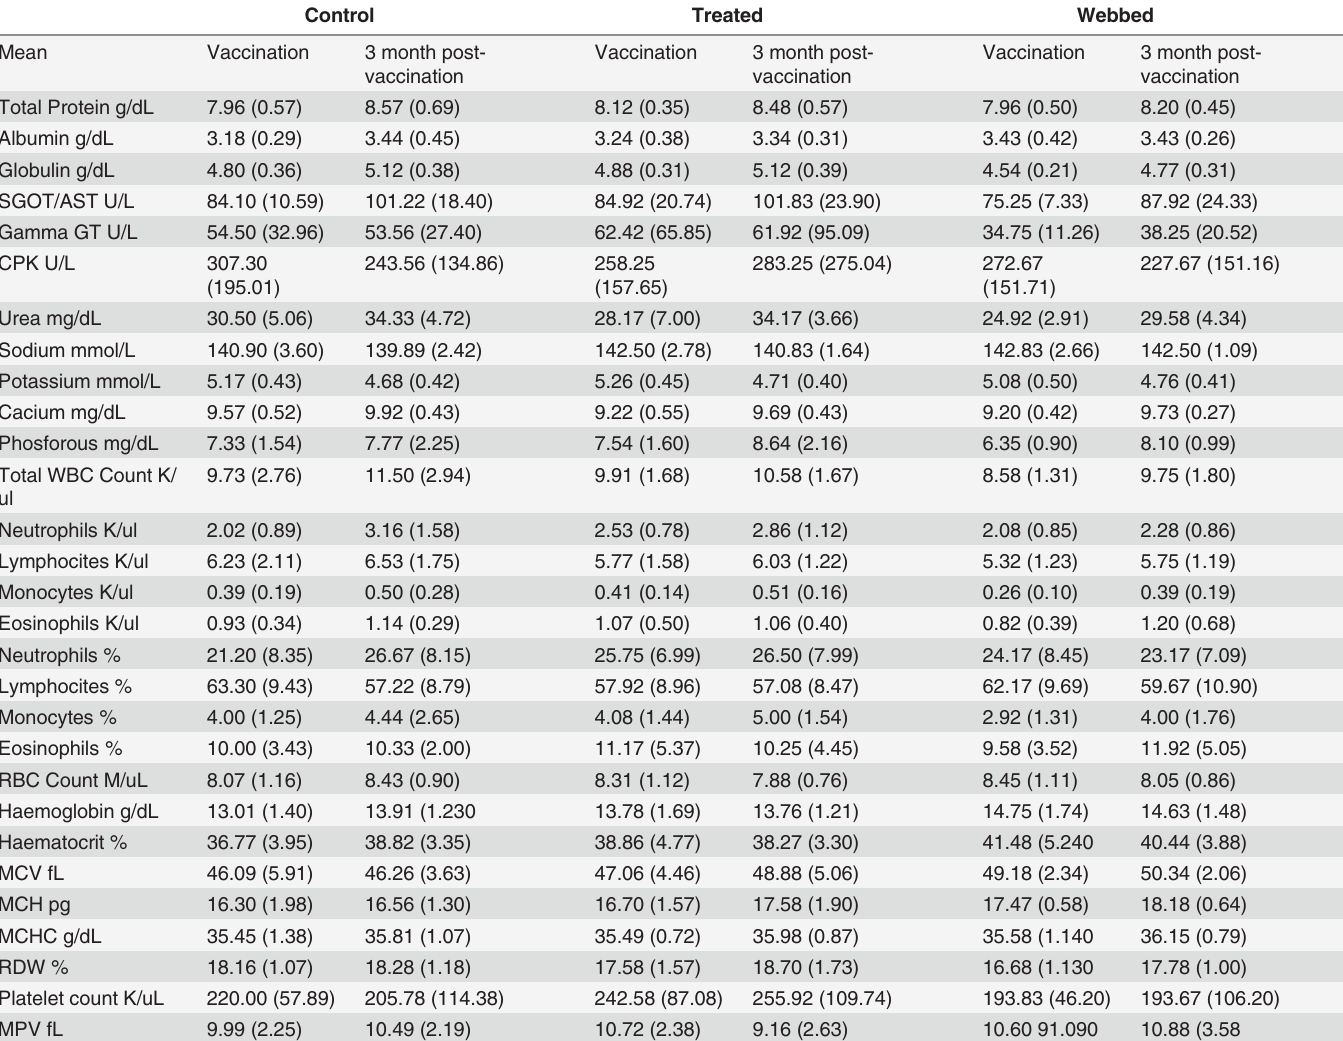
Table 1. Mean (SD) hematological and biochemical parameters of cattle at vaccination and three months after